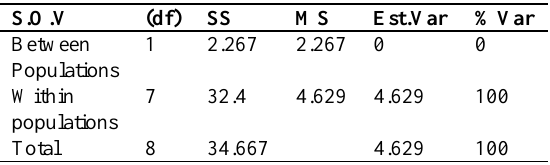
Table 6. Principal components analysis for seed storage pattern in M. piperita and M. spicata